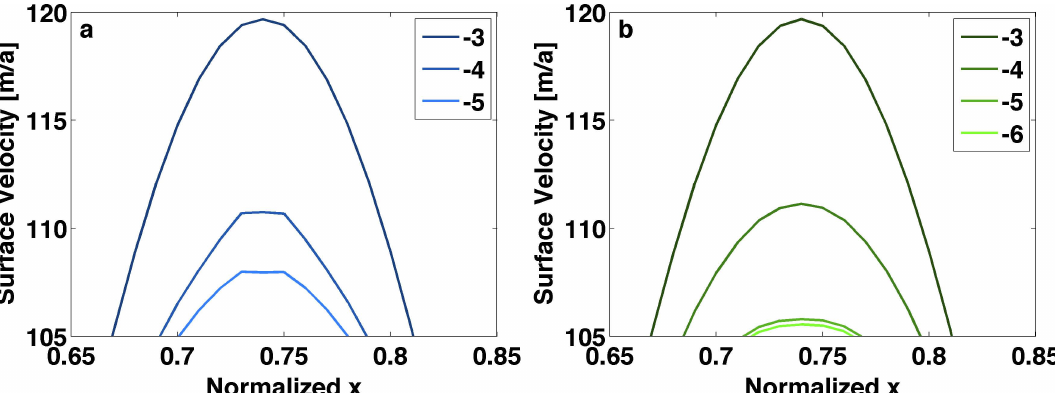
Fig. 5. Resultant surface velocity fields in the ISMIP-HOM test A on the largest domain of 160km for the DIR discretisation (a) and the STAG discretisation (b) . This is a close-up view of the zone of high deformation where the x -component of the bedrock gradient changes its sign. The legend entries refer to different convergence tolerances expressed in the exponent of 10. For a low tolerance, both discretisations find a solution close to the initial SIA velocity (not depicted). With increasing accuracy the resultant velocity fields converge to a solution with lower maxima. However, the DIR field levels out at the maxima and even shows a local minimum for the highest